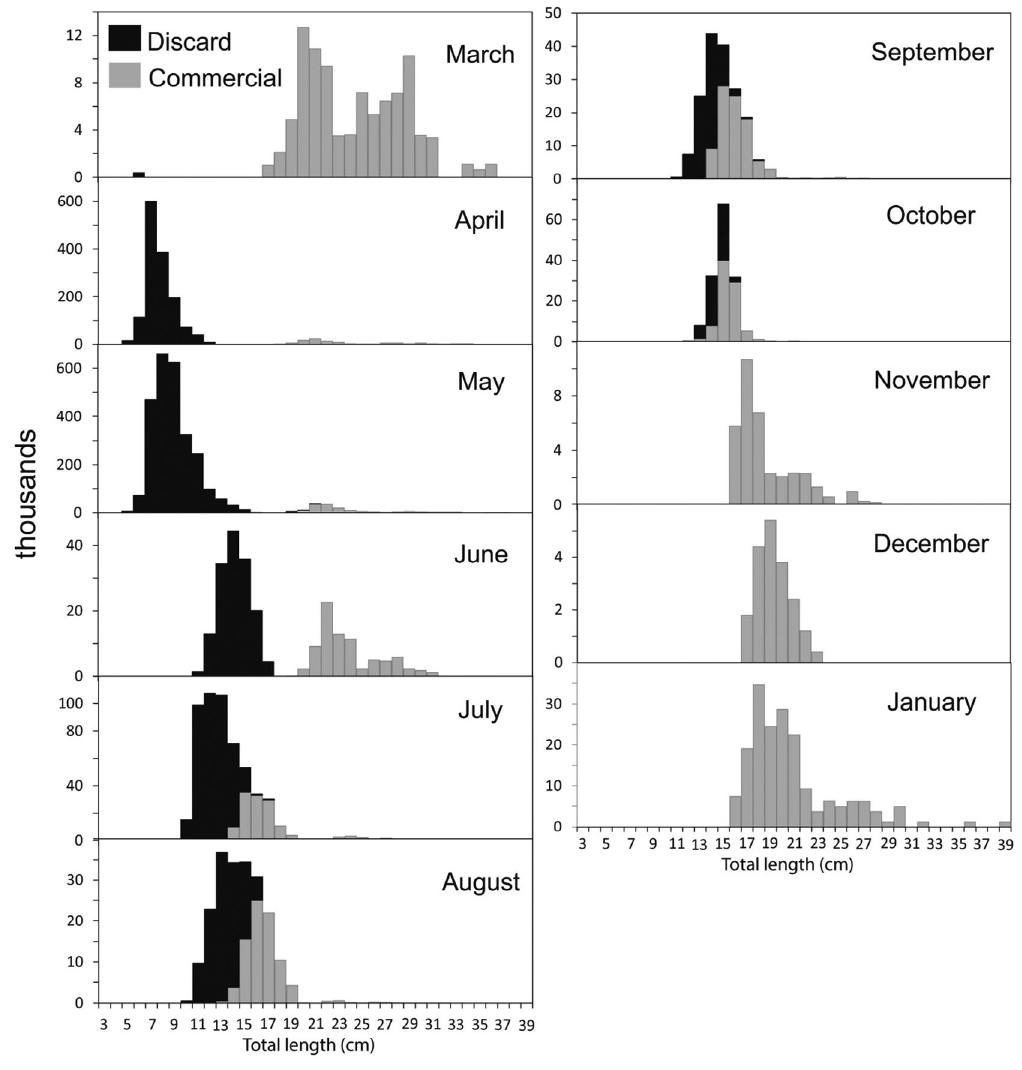
Fig. 4. − Monthly length frequency distributions of the commercial (grey) and discarded (black) blue whiting catch in the fishing port of Roses from March 2017 to January 2018. A temporal closure for bottom trawling was implemented in February. A minimum conservation reference size was set to 15 cm TL on the Catalan coast. Note the different scales of the